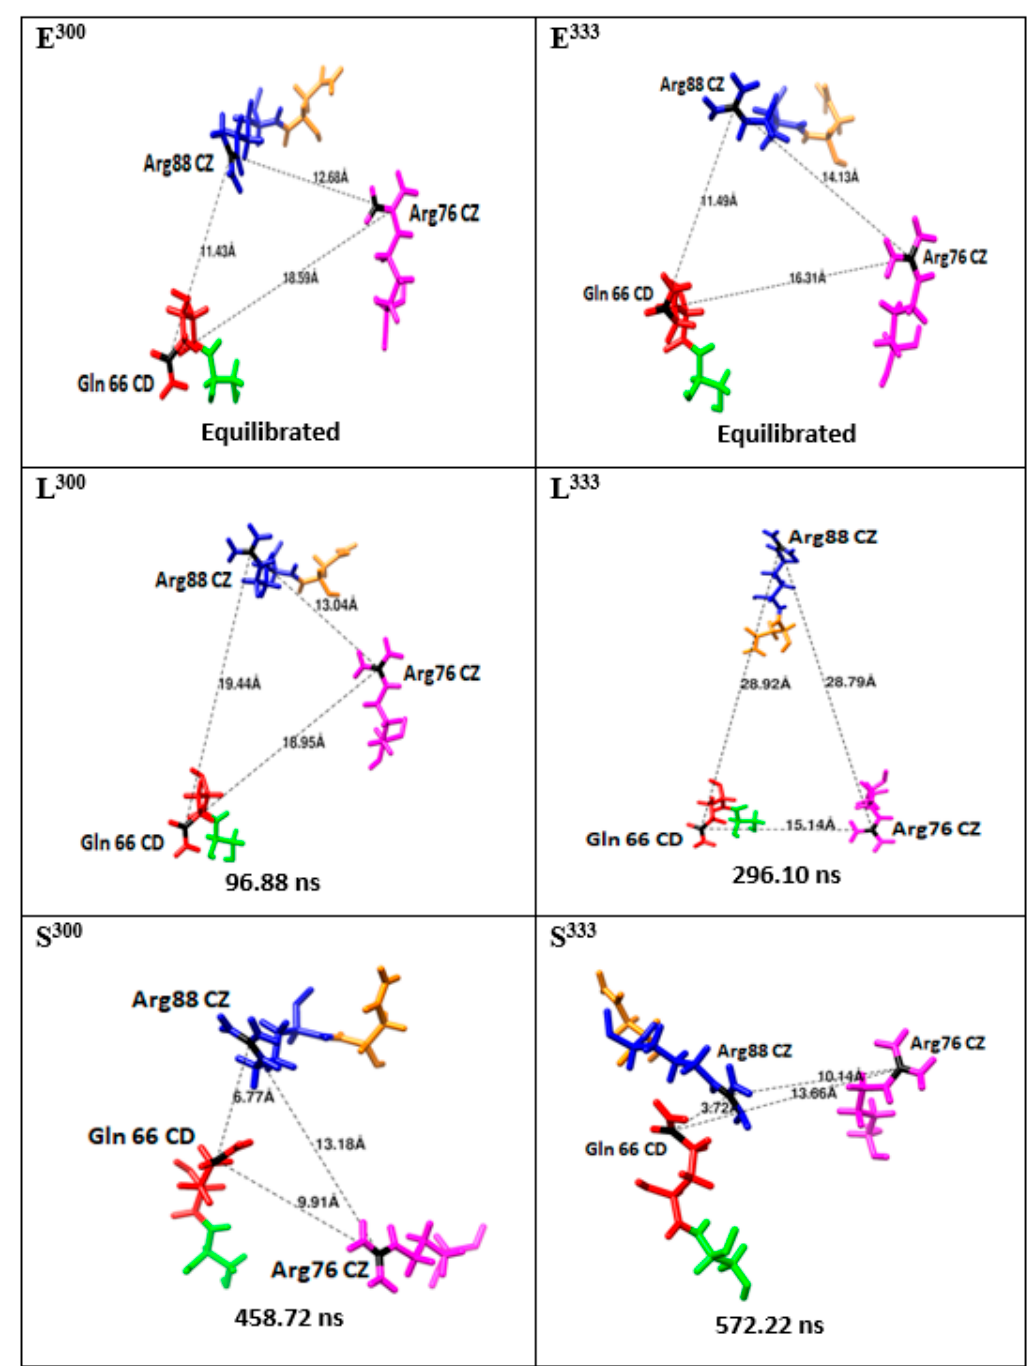
Figure 7. Inter-residue distances between key substrate channel entrance residues of P450-TT enzyme, over the course of the 600.5 ns MD simulations at 300 and 333 K, showing their distances at equilibration (E 300 and E 333 ), and their longest (L 300 and L 333 ) and shortest (S 300 and S 333 ) distances.